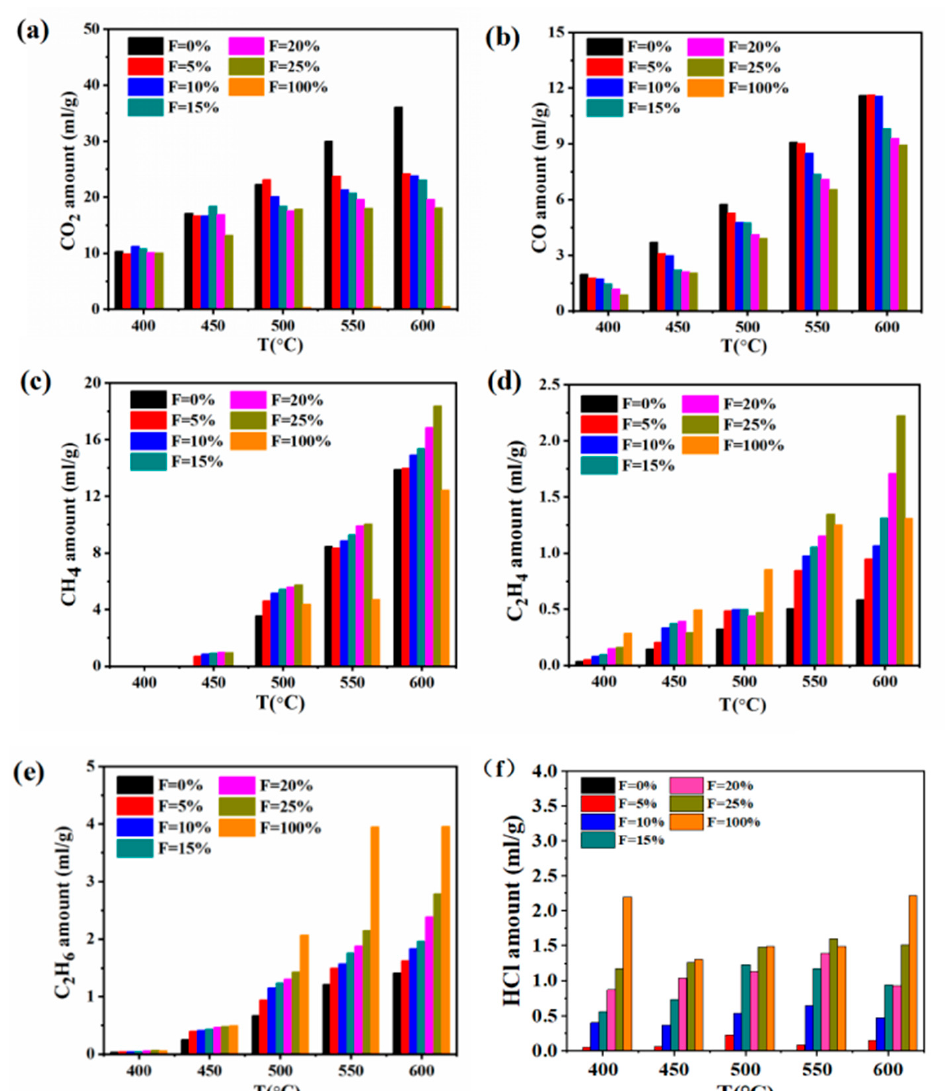
Figure 4. ( a ) CO 2 , ( b ) CO, ( c ) CH 4 , ( d ) C 2 H 4, and ( e ) C 2 H 6 release amount of pyrolysis with different PVC additions. ( f ) HCl release amount of pyrolysis with different PVC additions.